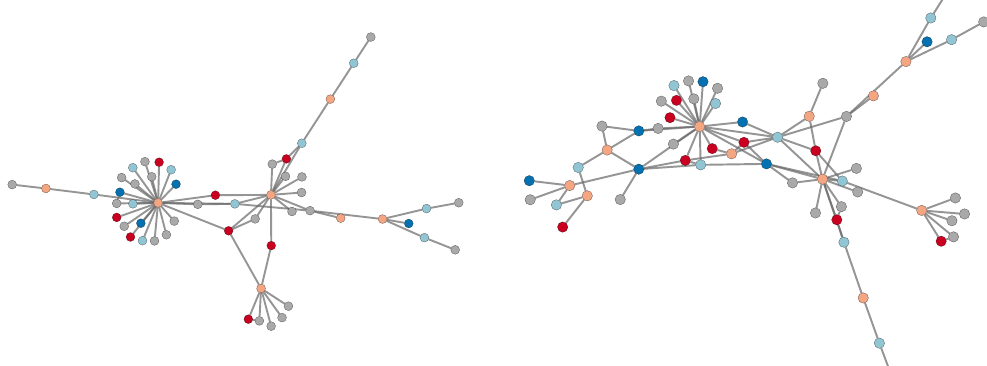
Figure 8. The contracted line graphs L C ( G ) of the road network in the central archaeological area, as in the current situation (left) and in the project (right).